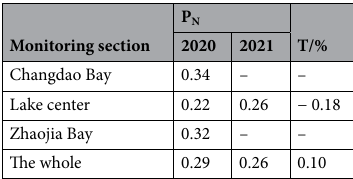
Monitoring section